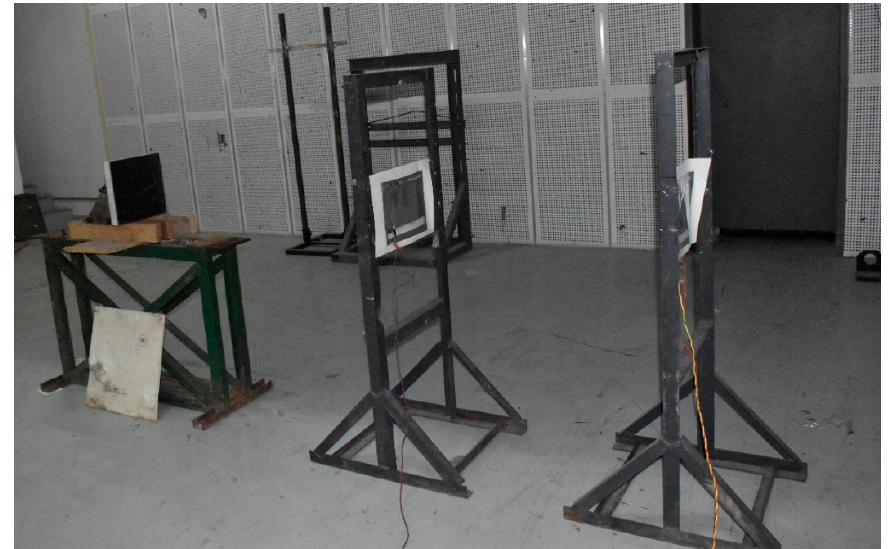
Figure 8. Layout of the ballistic impact experiment.